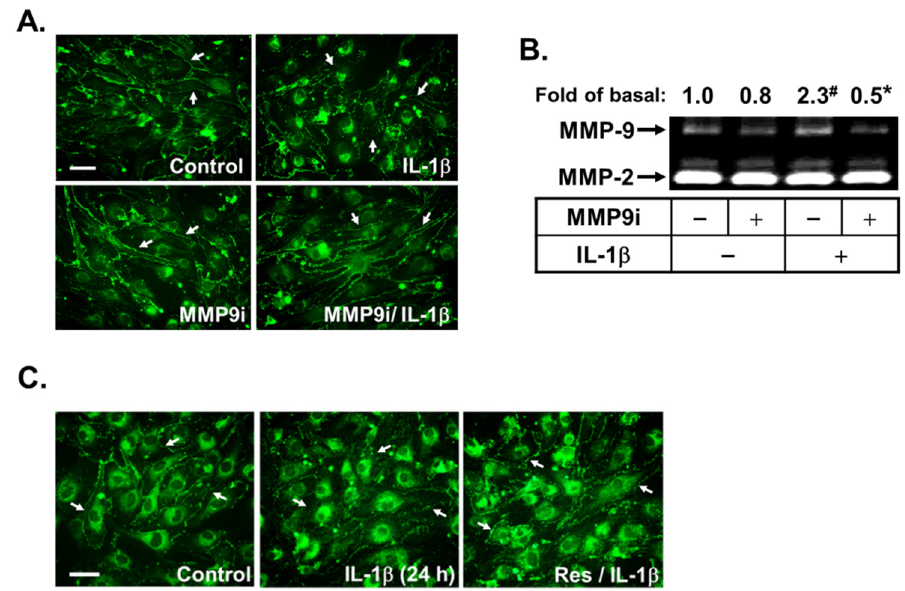
Figure 6. Effect of resveratrol on MMP-9-mediated destruction of tight junction protein ZO-1 arranged integrity in response to IL-1 β treatment. ( A ) Cells grown on coverslips were pretreated with MMP-9 inhibitor (MMP9i, 1 μ M) for 1 h and then exposed to IL-1 β (10 ng/mL) for 24 h. ( B ) After treatment, the conditioned media were collected and assayed as described in Figure 1. Quantitative data were analyzed by one-way ANOVA, as described in Methods. Data are expressed as the mean ± SEM ( n = 3); # p < 0.01, as compared with the untreated control; * p < 0.05, as compared with the respective values of cells stimulated with IL-1 β only. ( C ) Cells grown on coverslips were pretreated with resveratrol (Res, 1 μ M) for 1 h and then exposed to IL-1 β (10 ng/mL) for 24 h. Cells were fixed and stained with anti-ZO-1 antibody and a fluorescein isothiocyanate (FITC)-conjugated secondary antibody ( A , C ). The image represents one of three individual experiments (( A , C ), scale bar = 20 μ m). The white arrows point to the location of ZO-1 around the cell membrane.